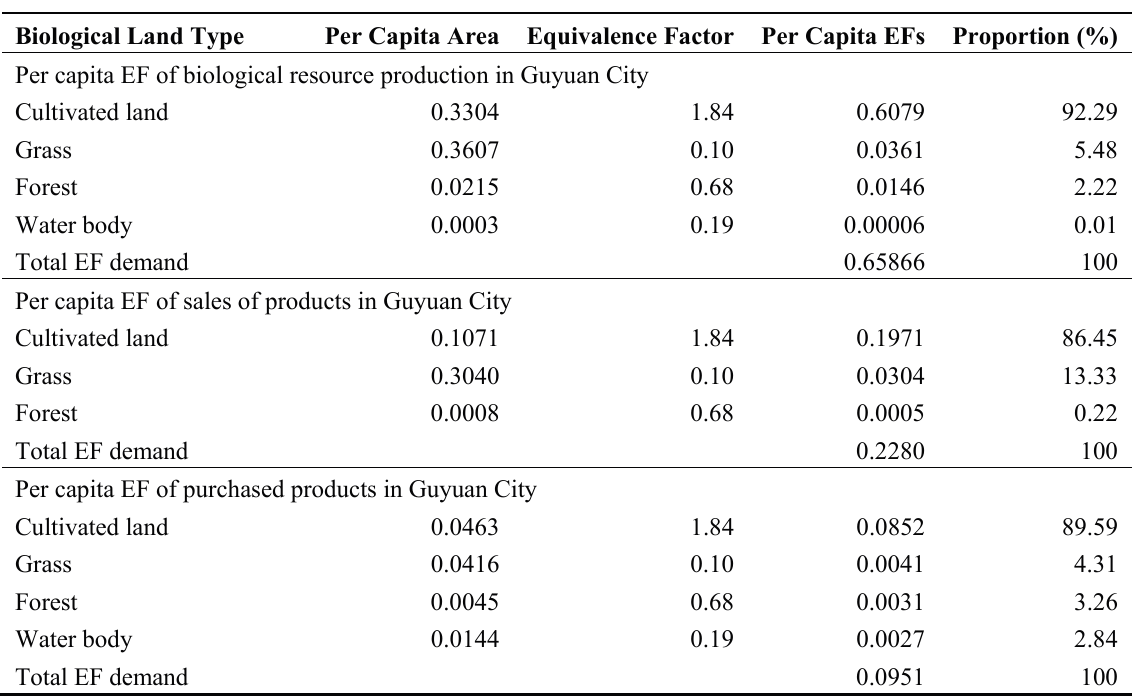
Table 1. EFs of bio-resource production, sales of products, and purchased products in Guyuan in 2012